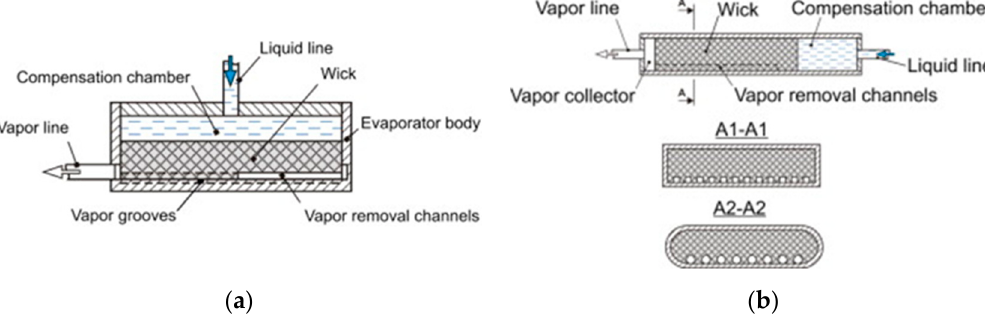
Figure 2. LHP evaporators ( a ) Opposite replenishment, ( b ) Longitudinal replenishment. Reproduced from [10], Y.F. Maydanik: 2014.